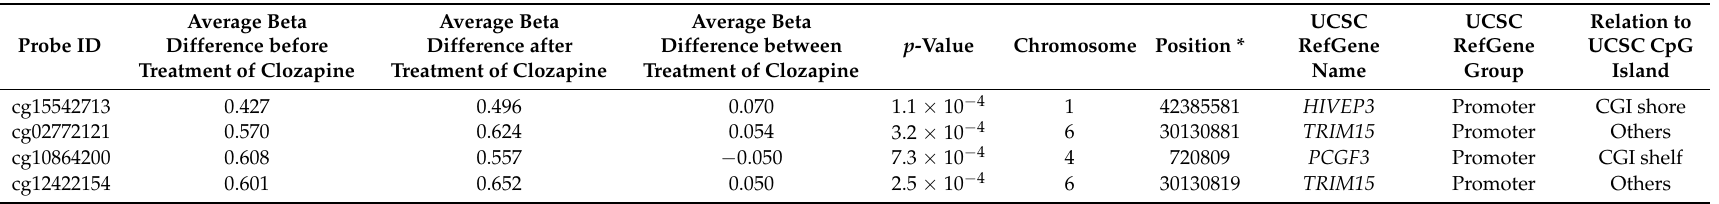
Table 1. A list of the significant CpG sites with average ∆ β > 0.05 and paired t -test p -value < 0.001 in the gene promoter regions. CGI, CpG island; UCSC, University